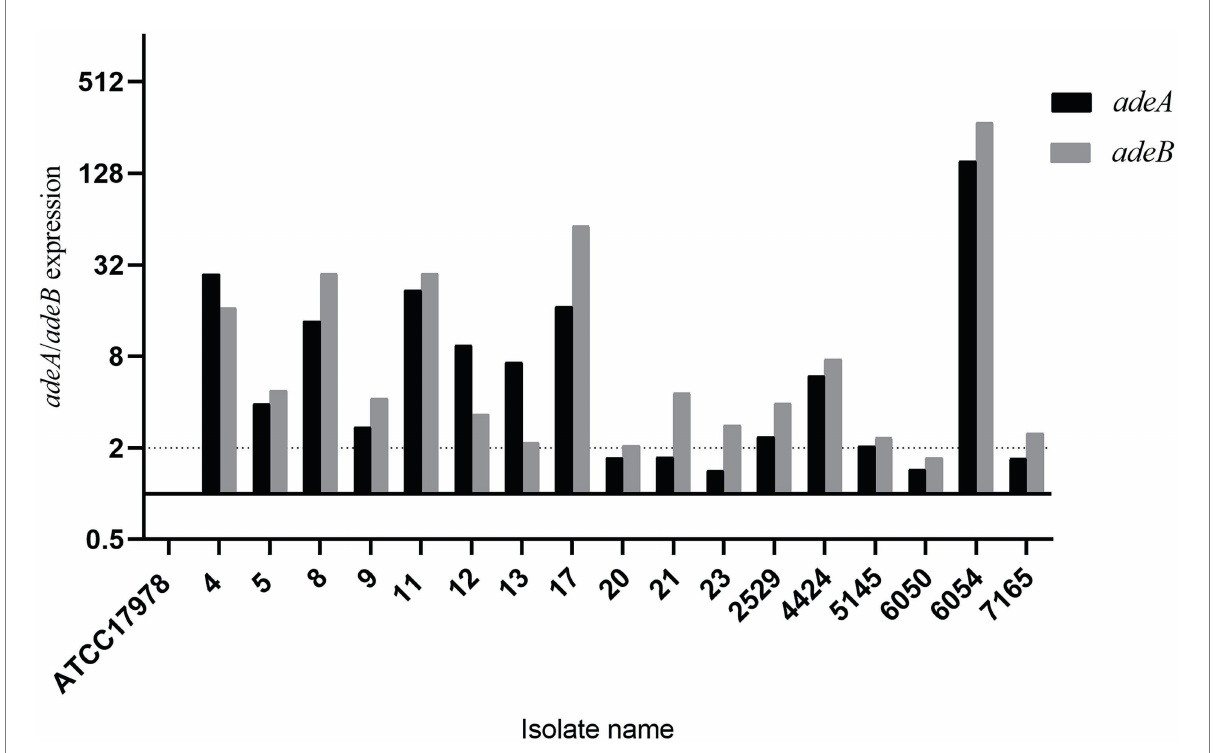
FIGURE 4 Expression of the AdeABC efflux pump genes adeA and adeB . ATCC17978 was used as a